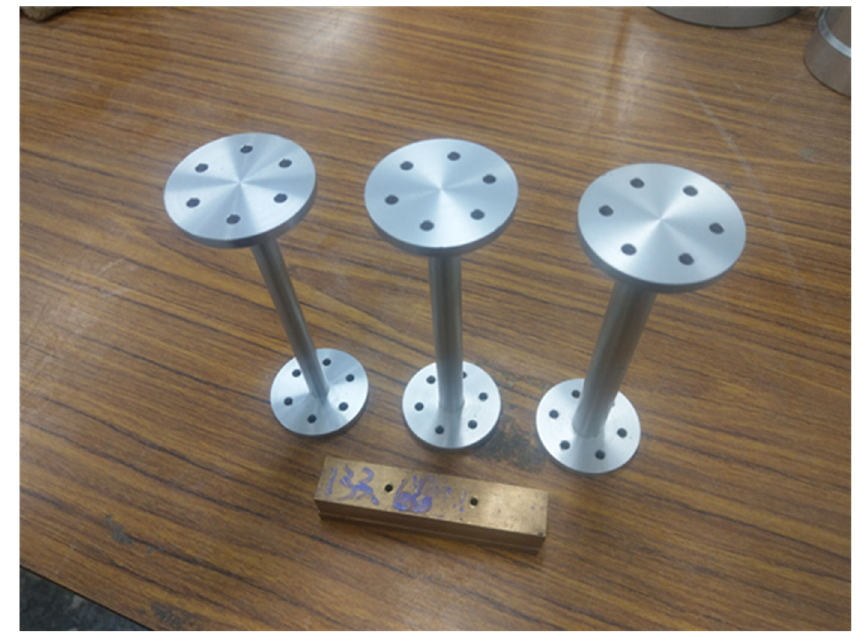
Figure 4. Aluminum calibration rods and calibration block used in this study.